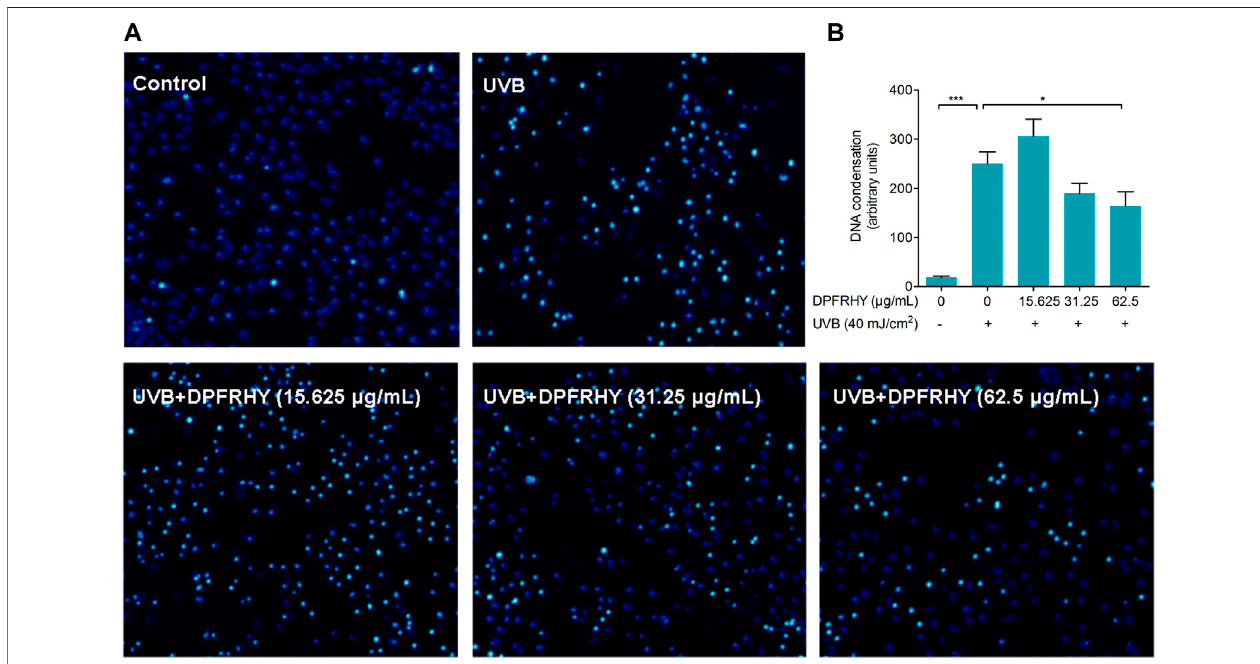
FIGURE 11 | Evaluation of apoptosis protection in UVB-irradiated L929 fi broblasts treated with DPFRHY. (A) DNA condensation formation was observed under a fl uorescence microscope following Hoechst 33342 staining. (B) The units statistics of DNA condensation in each fi eld of microscope.